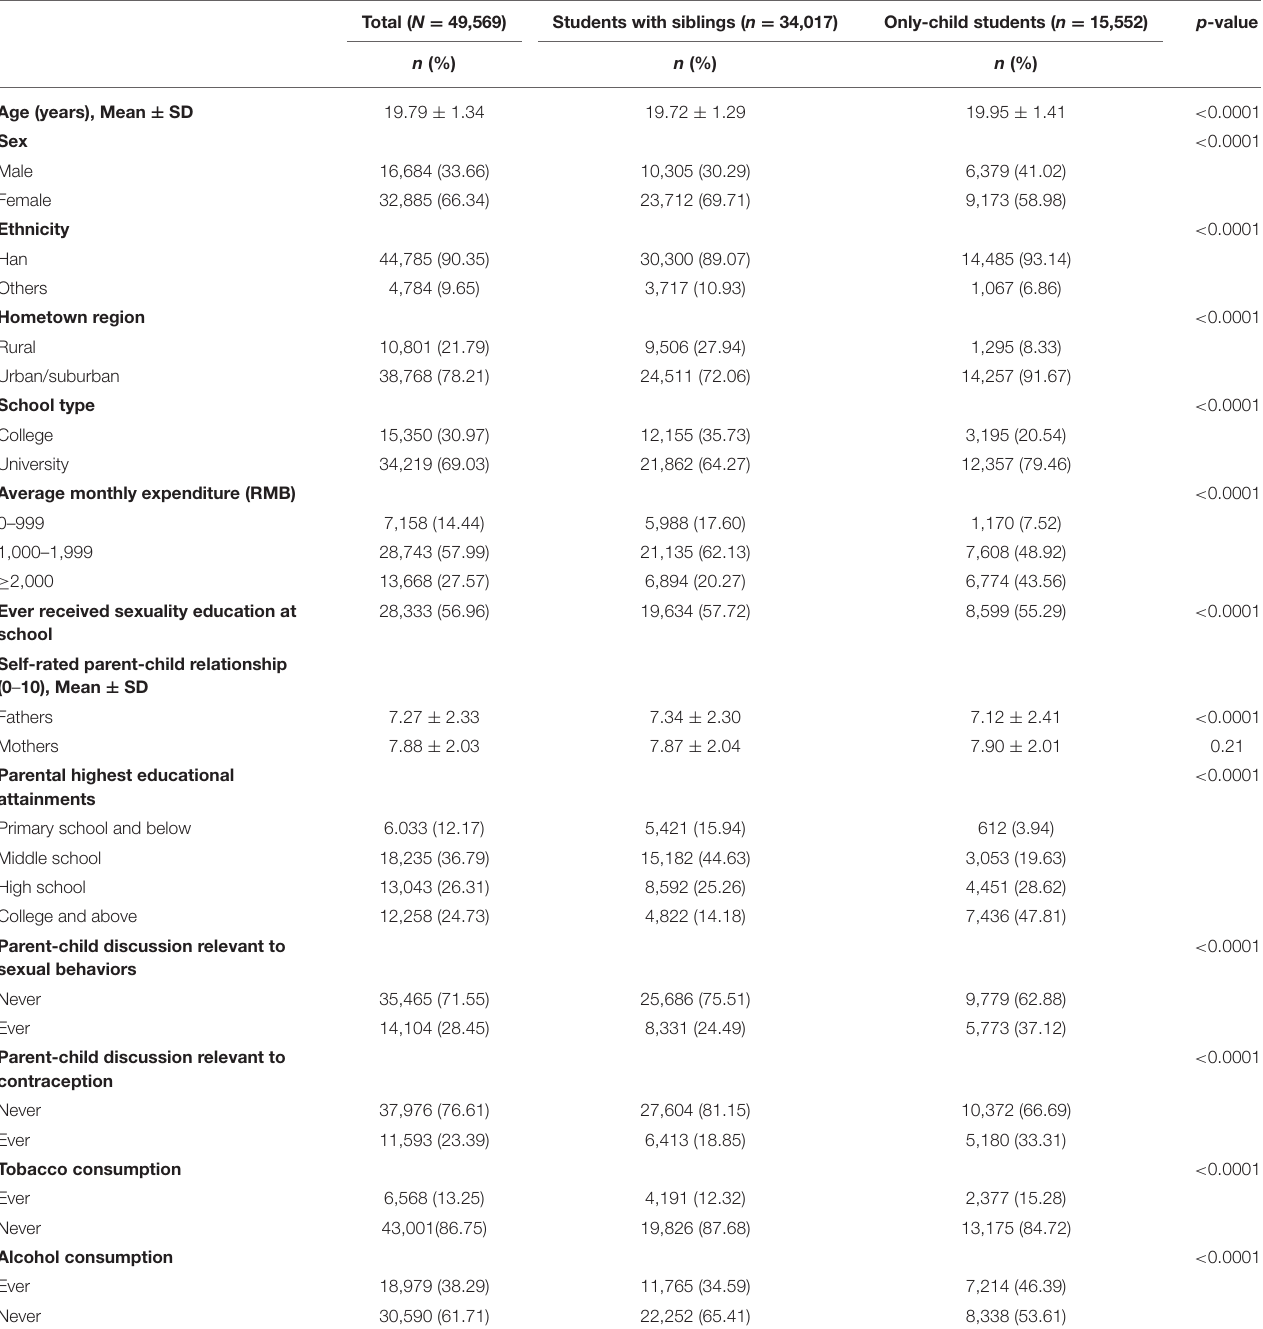
TABLE 1 | Socio-demographic characteristics of only-child students and students with siblings. Total ( N = 49,569) Students with siblings ( n = 34,017) Only-child students ( n =